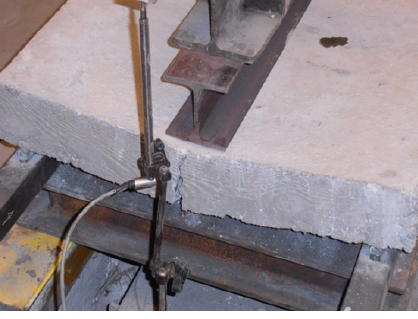
Figure 5: Collapse mode in the reference sample under bending Figure 6: Load vs displacement trend for the reference